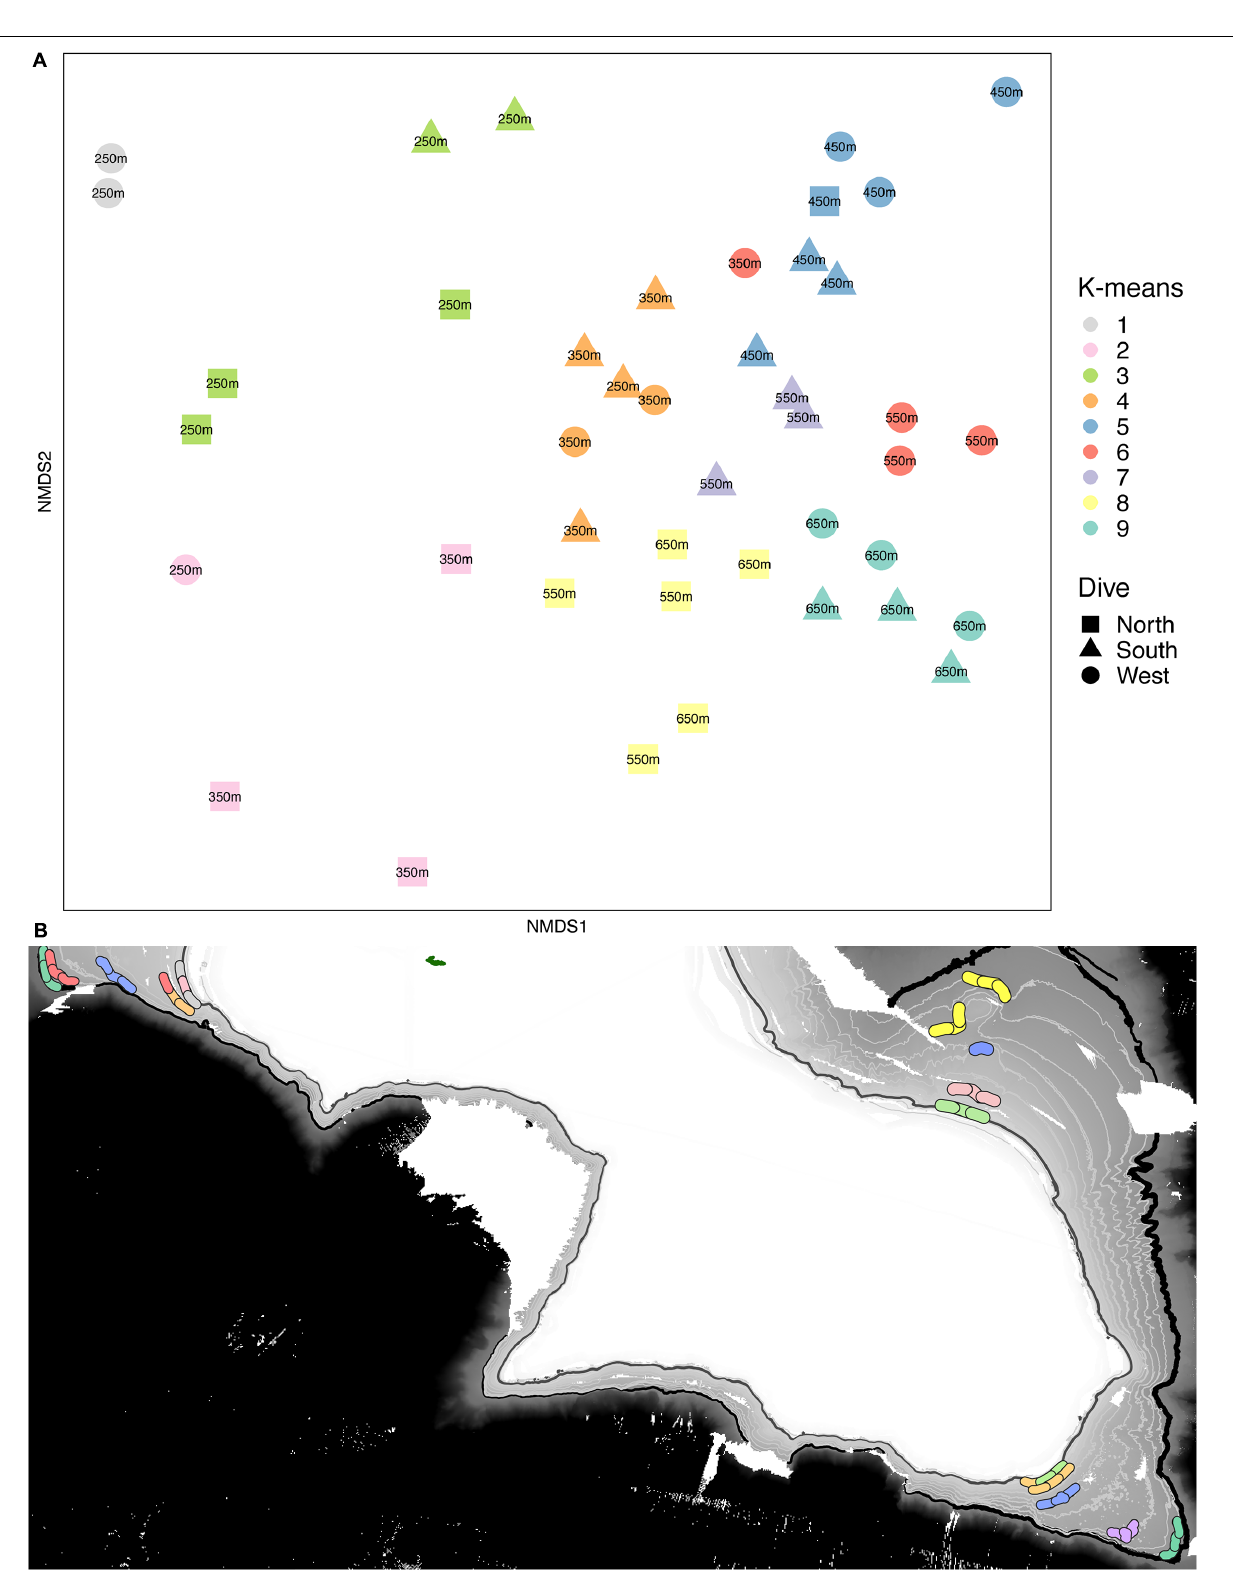
FIGURE 10 | (A) Non-metric multidimensional scaling plot for assemblage structure of Mokumanamana color-coded by k-means clusters labeled by depth bin. (B) map with locations of transects denoted by their k-means clusters color code from (A) .